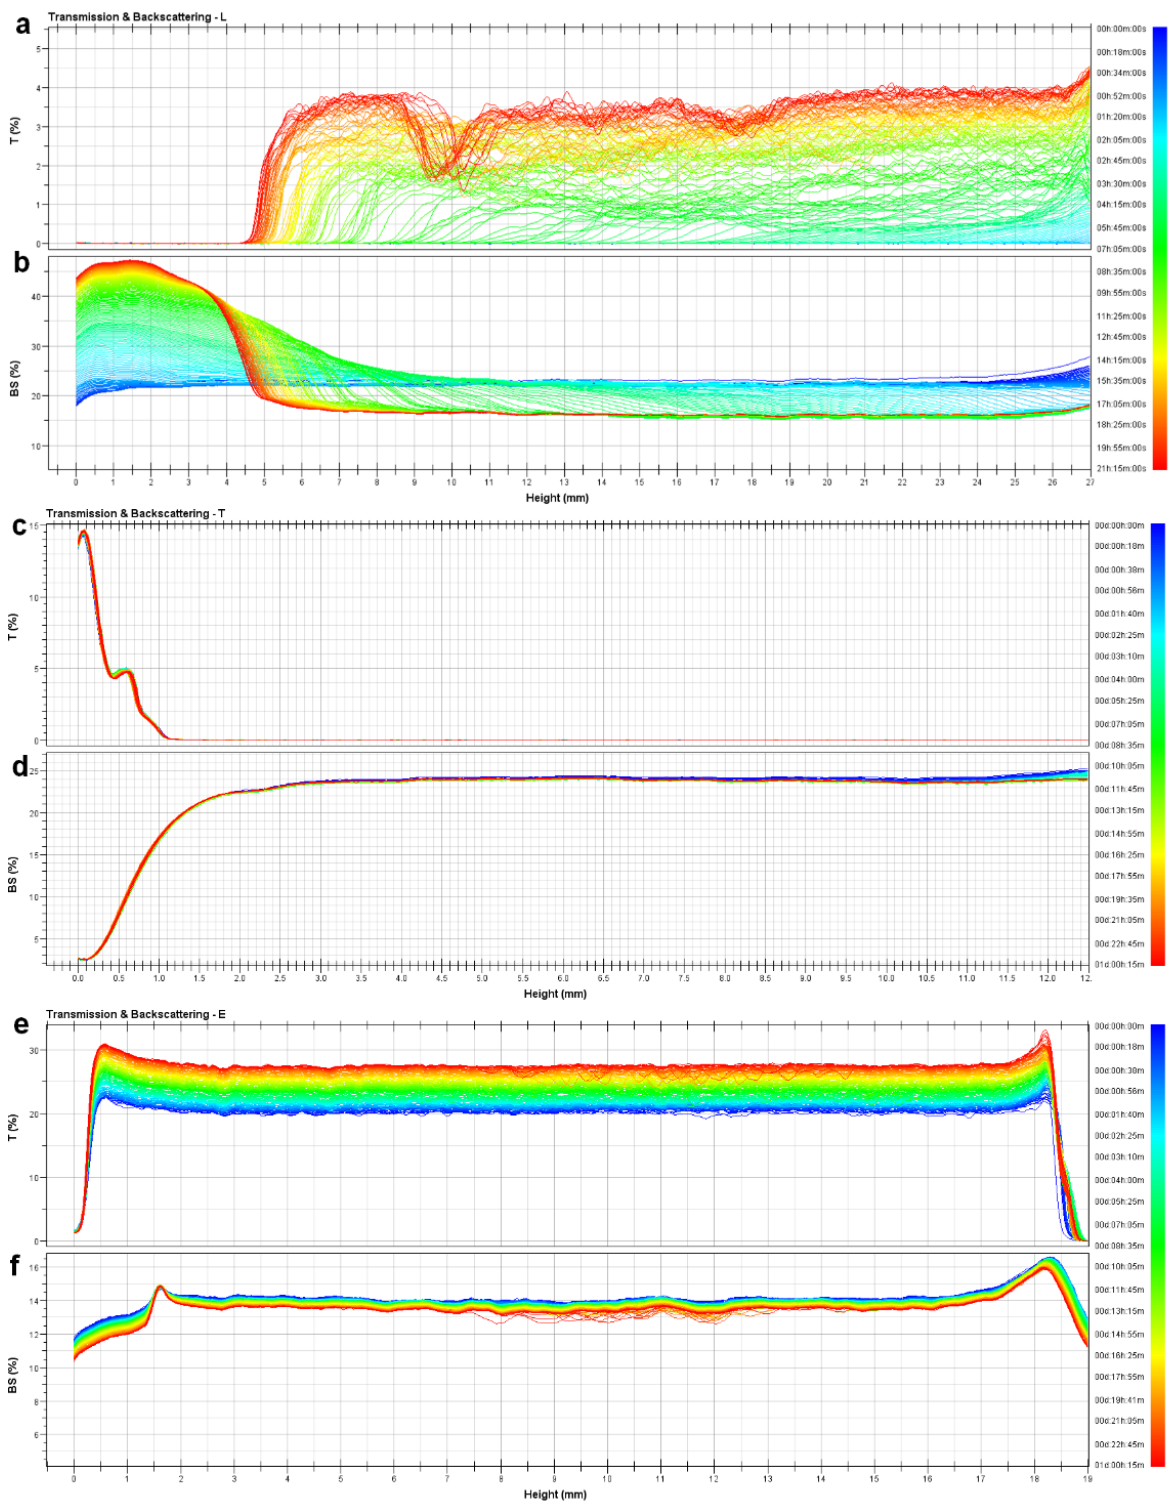
Figure 3. Short-term stability data: ( a ) L1 transmission data; ( b ) L1 backscattering data; ( c ) T1d transmission data; ( d ) T1d backscattering data; ( e ) E1 transmission data; ( f ) E1 backscattering data.